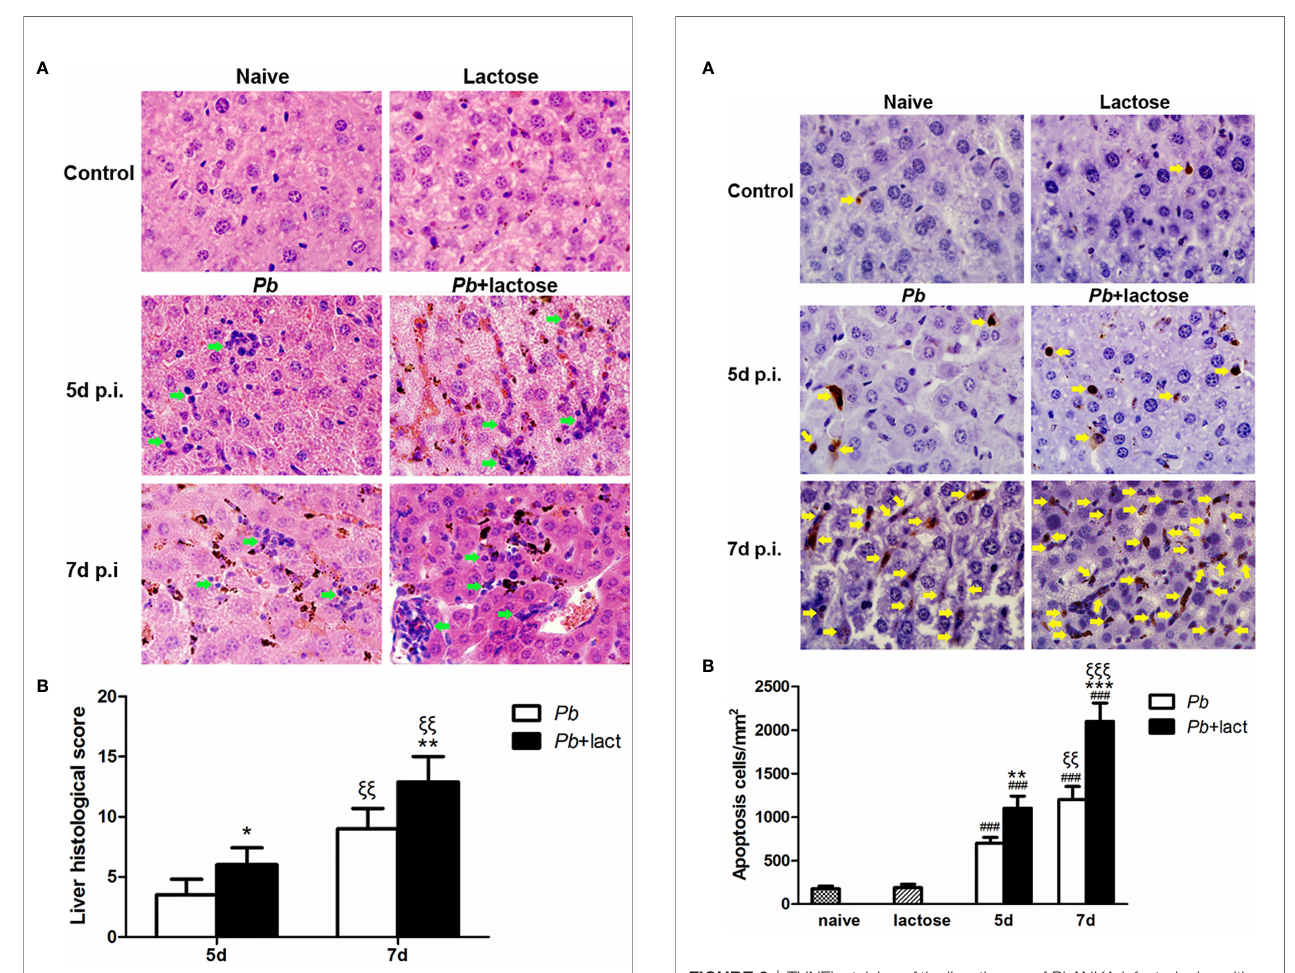
FIGURE 3 | TUNEL staining ofthe liver tissues of Pb ANKA-infected mice with or without a -lactose treatment. Shownare representative liver sectionsbyusing TUNEL staining. (A) Apoptoticcells inthe liversofnaive mice, mice with a -lactose treatment, malarial mice, and malarial mice with a -lactose treatment ondays5 and7 p.i.Apoptoticcells were indicated with yellow arrow heads. Original magni fi cation × 1,000. (B) Morphometric analysisof apoptoticcellsinthe liver tissues. Shownare apoptotic cells per square millimeter.Data are presented as means± SD;experiments were performed with 4 mice per group. ### P < 0.001, malarial mice on day 5 p.i., malarial mice with a -lactose treatment on day 5 p.i., malarial mice on day 7 p.i., and malarialmicewith a -lactose treatment on day 7 p.i. vs . naive group; ** P < 0.01, malarial mice with a -lactosetreatment on day 5 p.i. vs . malarial mice on day 5 p.i.; xxx P < 0.001, malarial mice with a -lactose treatment onday 7 p.i. vs . malarial mice with a -lactose treatment on day 5 p.i.; *** P < 0.001, malarial mice with a -lactose treatment on day 7 p.i. vs . malarial mice on day 7 p.i. xx P < 0.01, malarial mice onday 7 p.i. vs . malarial mice on day 5 p.i.